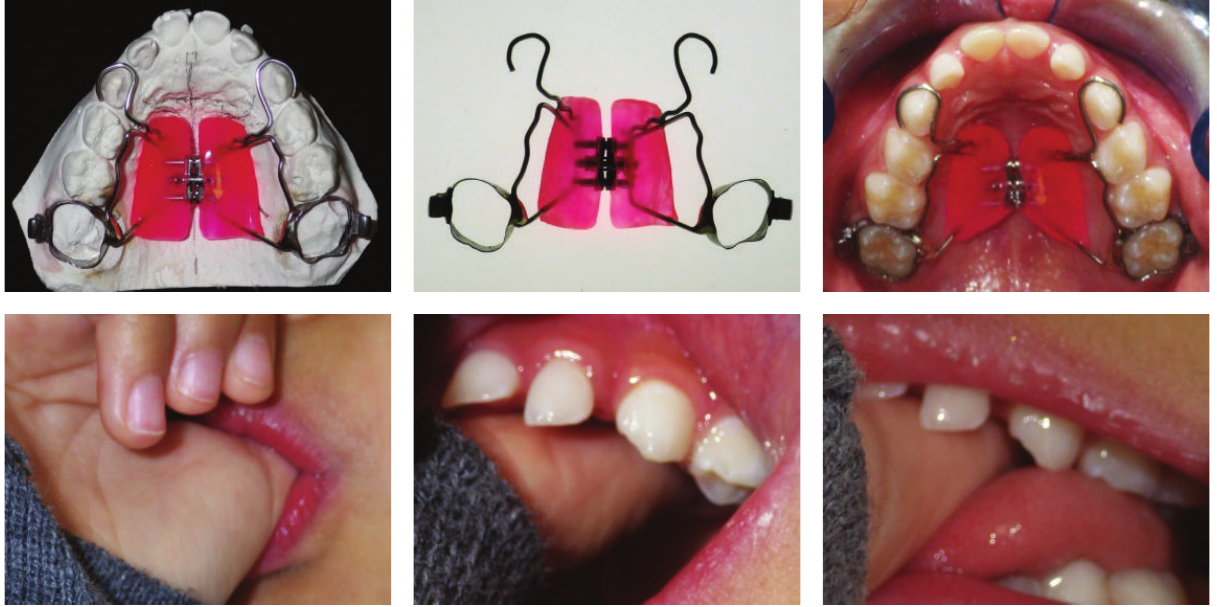
Figure 2: The expander before and after fixation. Thumb sucking